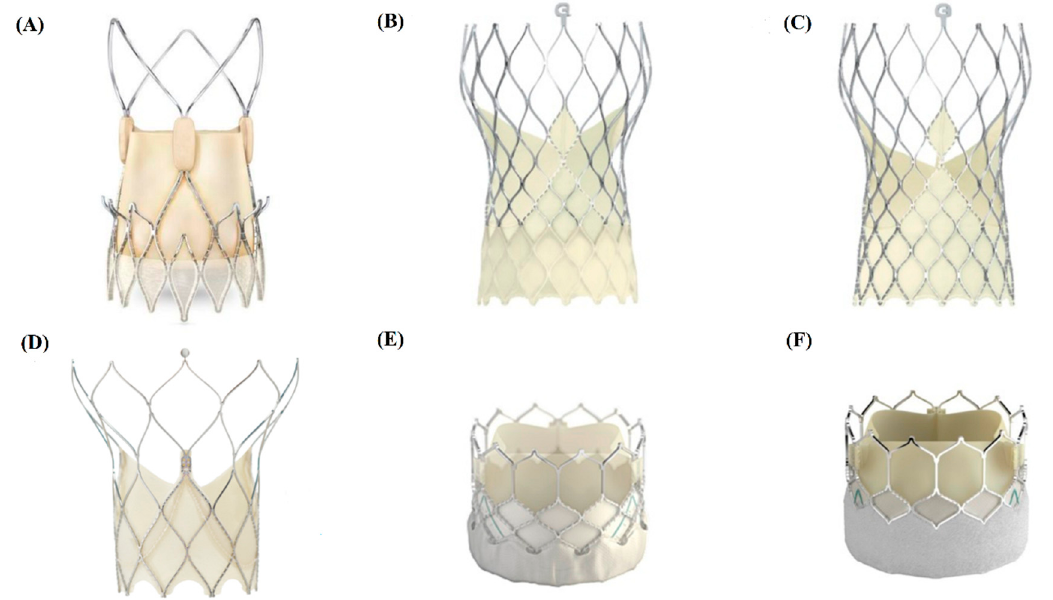
Figure 1. TAVI valves included in the current study. ( A ) Acurate Neo (Boston Scientific SciMed Inc, Maple Grove, MN, USA); ( B ) Evolut PRO (Medtronic, Minneapolis, MN, USA); ( C ) Evolut R (Medtronic, Minneapolis, MN, USA); ( D ) Portico ® valve (St. Jude Medical, St. Paul, MN, USA); ( E ) SAPIEN 3 (Edwards Lifesciences, Irvine, CA, USA); ( F ) SAPIEN 3 Ultra (Edwards Lifesciences, Irvine, CA, USA).